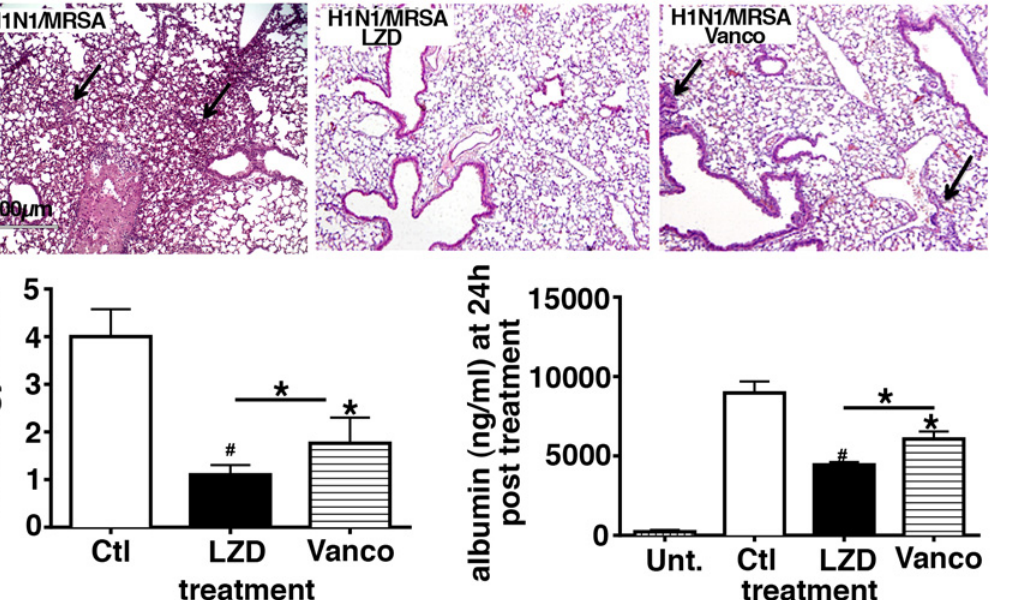
Figure 3. Mice treated with LZD have significantly lower lung injury as measured by protein leak as compared to Vanco or saline treated animals post bacterial challenge. WT mice were infected with H1N1 100 pfu i.n. and on day 7 challenged with 5×10 7 cfu cMRSA i.t., infected mice were treated with either vehicle or antibiotics LZD (80mg/kg i.p.) or Vanco (110 mg/kg i.p.). Lungs were harvested 24 hours after bacterial challenge and fixed in formalin. Representative haematoxylin and eosin (H&E)-stained sections of vehicle and antibiotic treated animals 24 hours post bacterial challenge. Histology scores calculated. BAL was performed 24 hours post bacterial challenge and albumin measured by ELISA. n = 8 in each group, experiments repeated thrice. #p < 0.01, * p < 0.05 as compared to vehicle treated group. Error bars represent mean (cid:2) SEM.